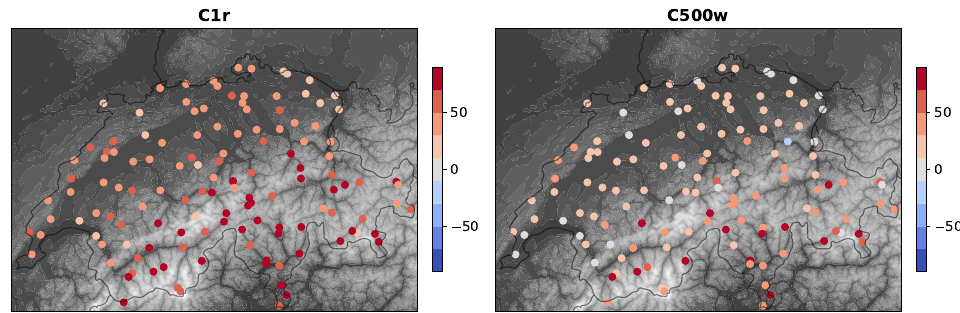
Figure A1. Evaluation of simulated diurnal pressure amplitude: Deviation (in %) of the ratio of the simulated to the observed mean diurnal pressure amplitude from the identify (average over the 18 valley wind days in September 2016) for the Swiss